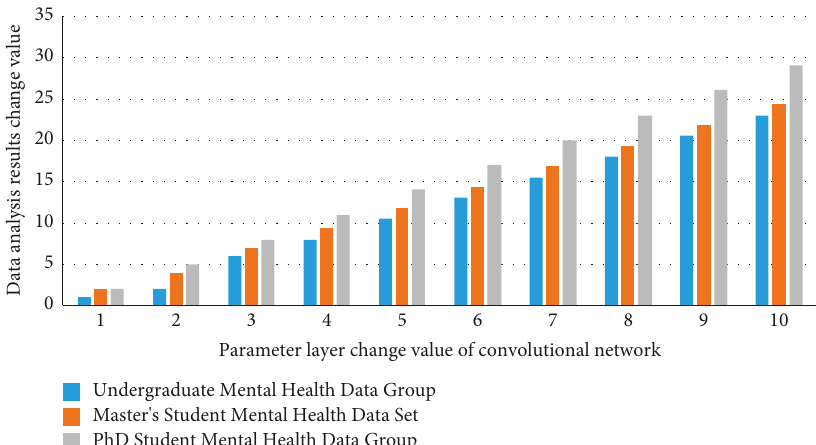
Figure 3: The results of data analysis of the mental health data of different college students using convolutional neural network.